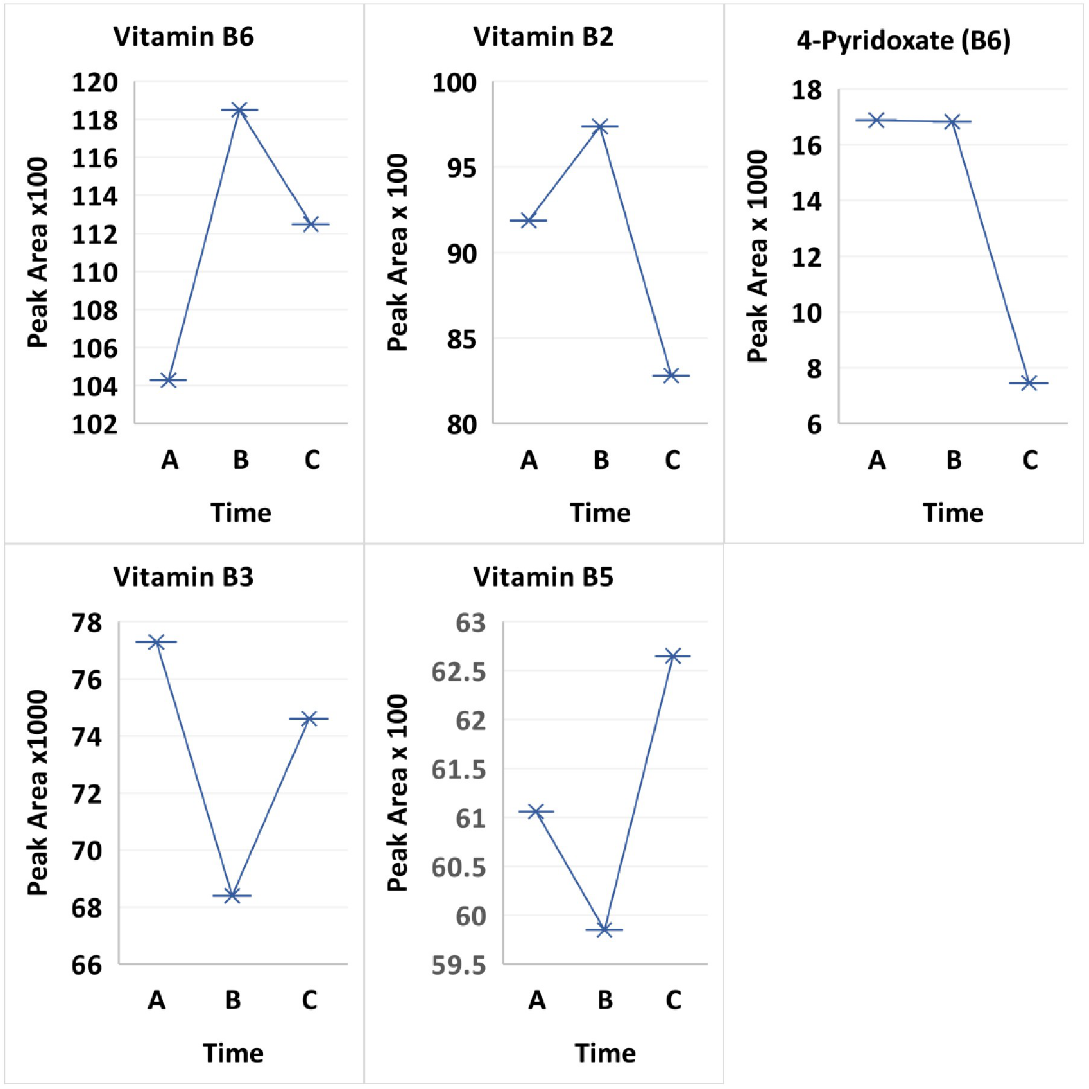
Fig 8. Comparison of treatment over 3 time points Time A at 6-12hours, Time B at 2 weeks and Time C at 3 months between all patients for metabolites vitamin B6, 4-pyridoxate the catabolic product of vitamin B6 and vitamin B2.